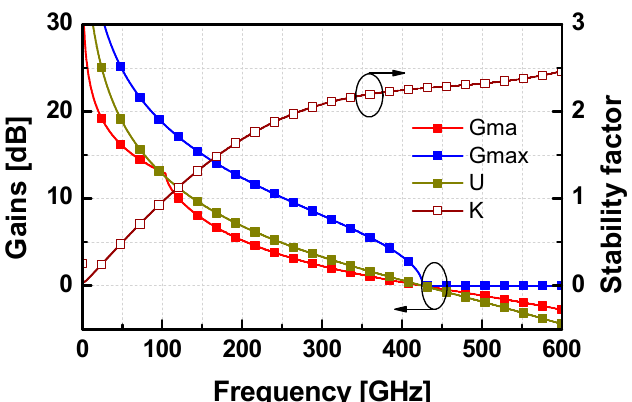
Figure 2. Power gains and stability factor of a post-layout extracted HBT with the emitter size of 2 × 70 nm × 900 nm.